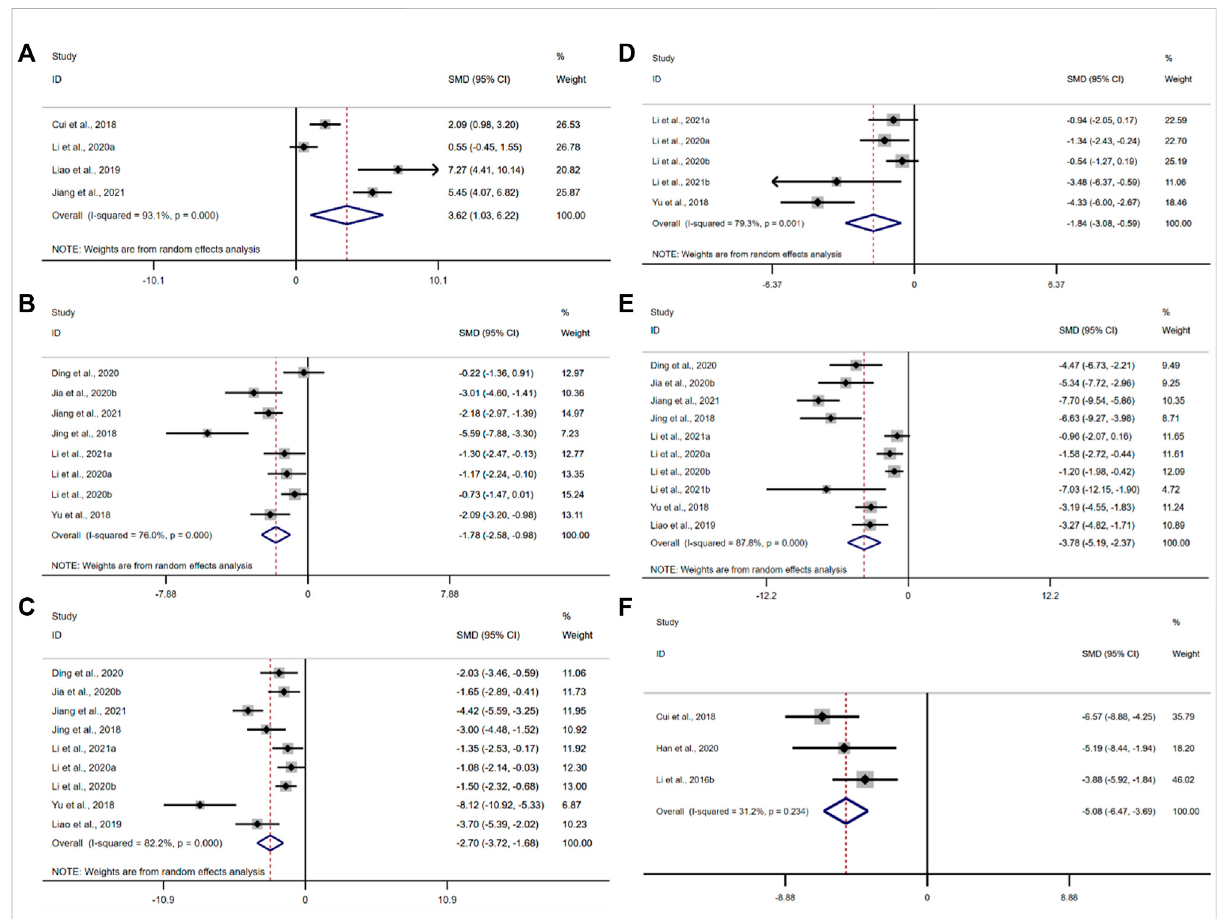
FIGURE 7 Forest plot: effect of berberine on (A) IL-10, (B) IL-1 β , (C) IL-6, (D) IFN- γ , (E) TNF- α , and (F) mRNA expression of interleukin 17.